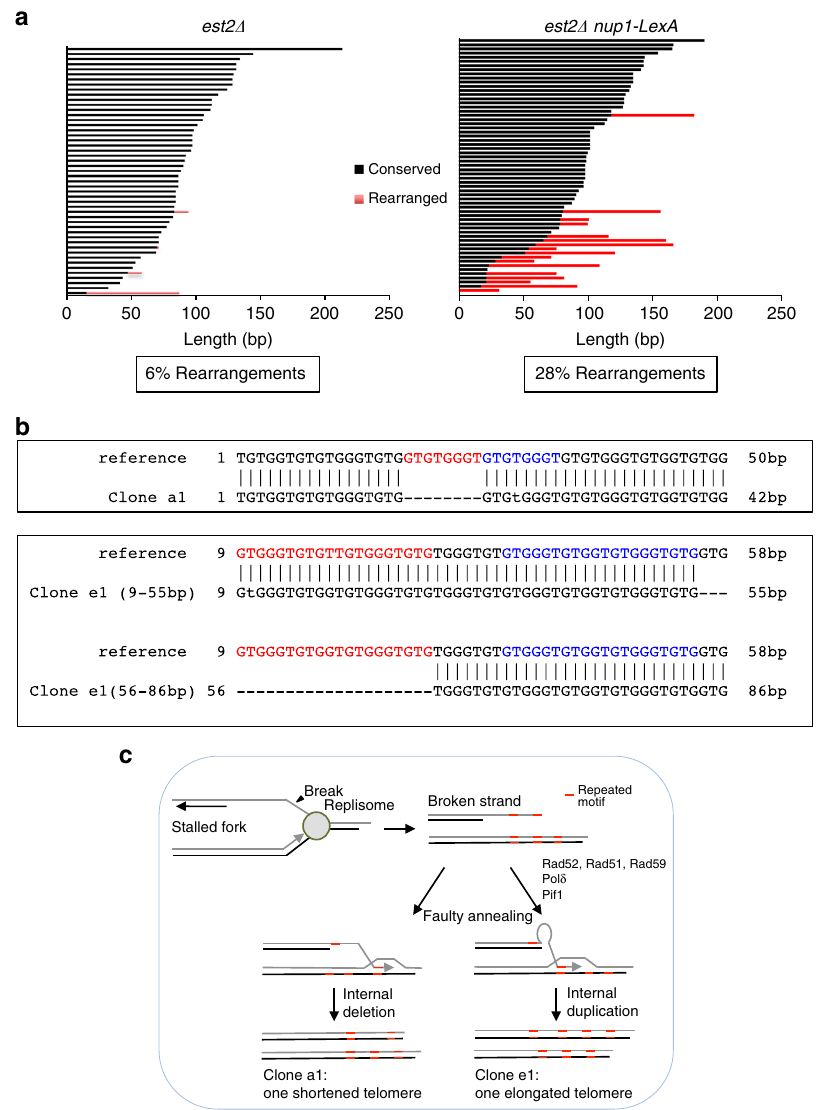
Fig. 5 Analysis of telomeres by DNA sequencing. a Telomeres VI-R were ampli fi ed and sequenced from clonal populations of est2 Δ and est2 Δ nup1-LexA cells using a speci fi c primer after about 65 population doublings from the initial spores (Day 5) and align with the reference sequence obtained at Day 1 (see Supplementary Fig. 4a for the senescence pro fi les). Each bar represents an individual telomere. Bars are sorted by the length of the centromere- proximal sequence that is identical to the reference sequence (black). The red bars show the length of the distal rearranged sequence that cannot be continuously aligned with the reference. b Examples of rearrangements. Upper panel, deletion: TelVI-R from the clone a1 aligns with the reference provided that a 8-bp-long gap is introduced after the 17th nucleotide. Note the repeated motif (in red and blue) at and after the gap. Lower panel, insertion: The 55 fi rst nucleotides of the clone e1 align perfectly with the reference. The last 60 nucleotides (56 – 86 are shown) cannot be aligned with the reference except if starting at position 29 of the reference instead of 56. This suggests that part of the sequence has been duplicated. Note the presence of the motif (in blue) at the end of the conserved sequence that is repeated just upstream the point of misalignment (in red). c Model of non-conservative HR-dependent repair between sister chromatids. The sequence of the telomeres contains motifs that are repeated several times. Thus a 3 ′ terminal end with such a motif can anneal at different positions in the sister chromatid to initiate repair leading to internal deletion (left part) or duplication (right